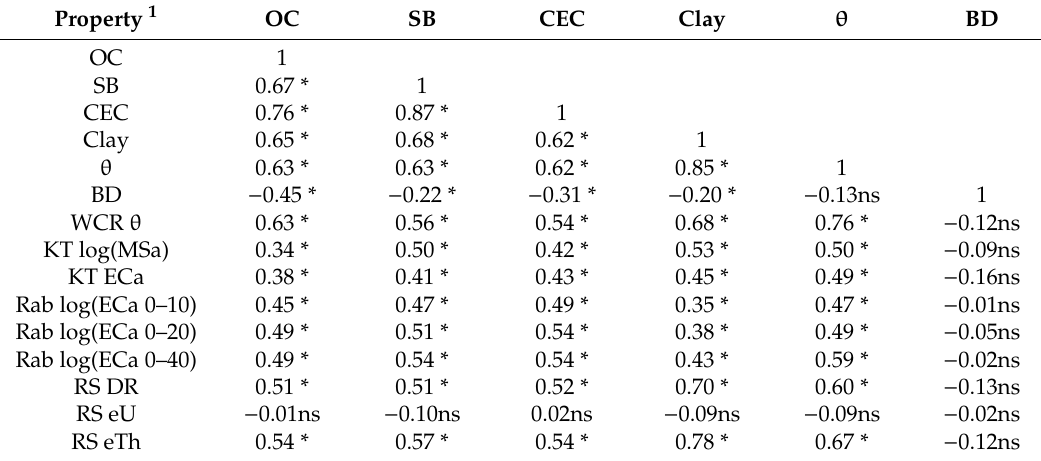
Table 2. Linear correlations among laboratory- and sensor-measured soil